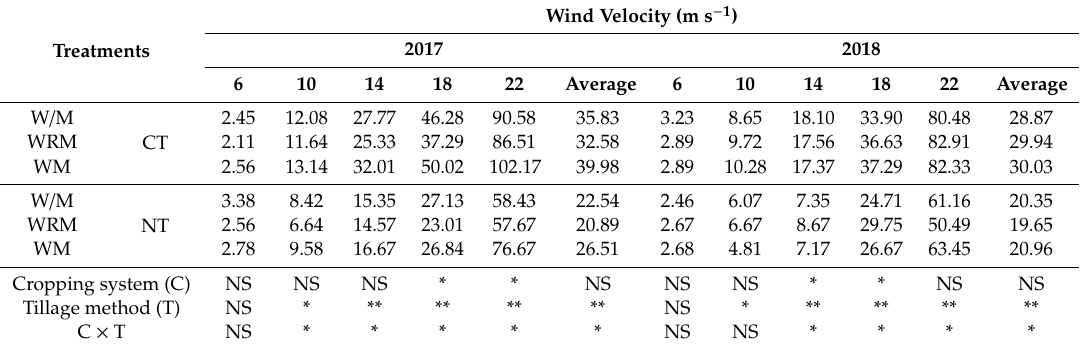
Table 2. Rates of soil wind erosion (g m − 2 min − 1 ) as a ff ected by cropping system, tillage method, and wind velocity in 2017 and